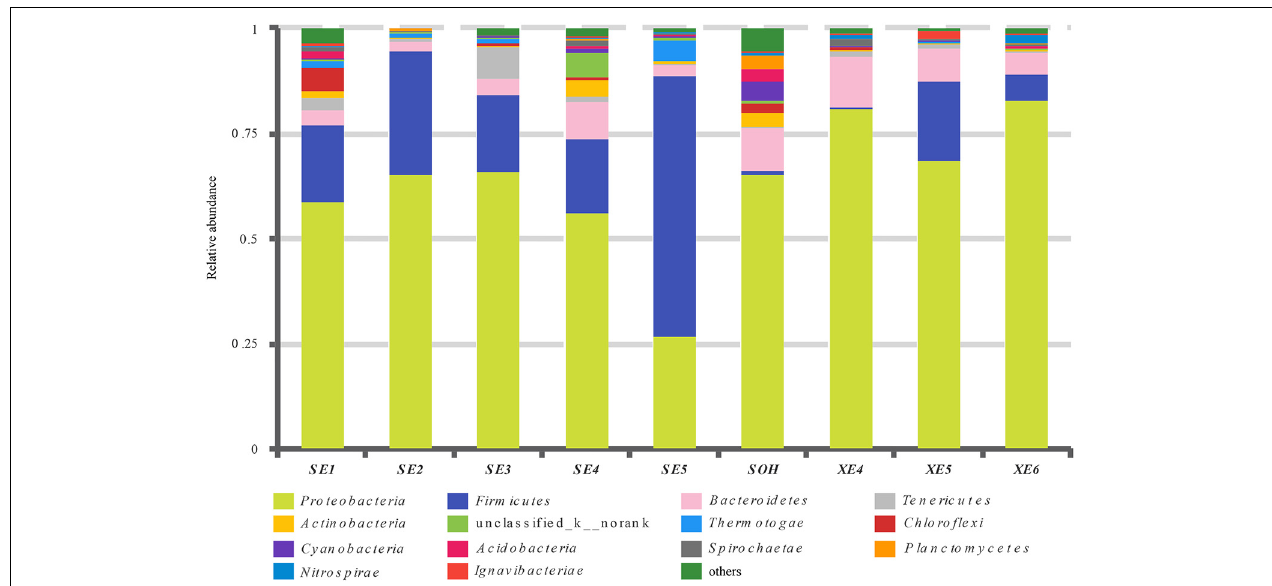
FIGURE 3 | Relative abundances of bacterial 16S rRNA gene sequences from the corrosion samples presented at the phylum level.